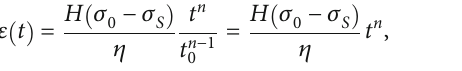
Table 5: Parameters of improved nonlinear viscoelastoplastic rheological model based on burgers model under 70% axial ultimate load.